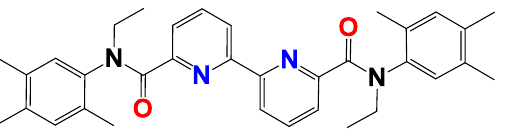
Figure 1. Struct ure of N,N’– diethyl –N,N’– bis(2,3,4 – trimethylphenyl) – [2,2 ′– bipyridine] – 6, 6′– dicar- boxamide (1)